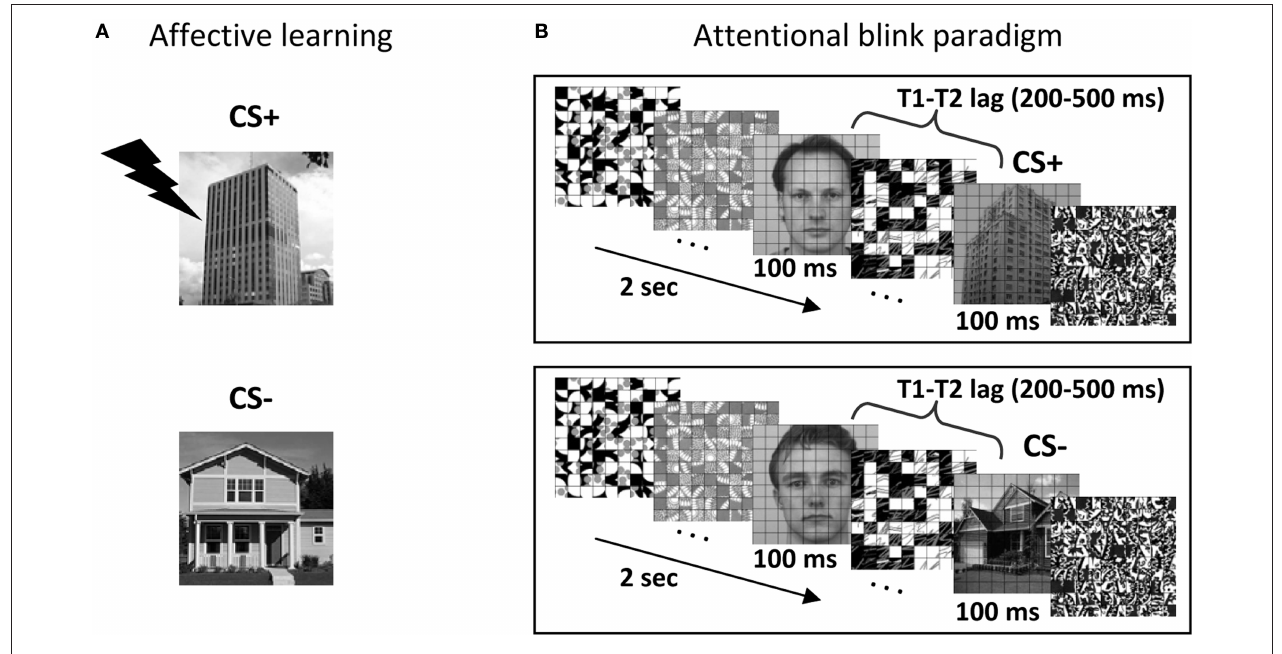
blink task, which involved reporting two target stimuli (T1: face; T2: scene) among a stream containing 18 distractors. T2 stimuli could be a CS + (building; top panel), a CS − (house; bottom panel) or a distractor stimulus (not